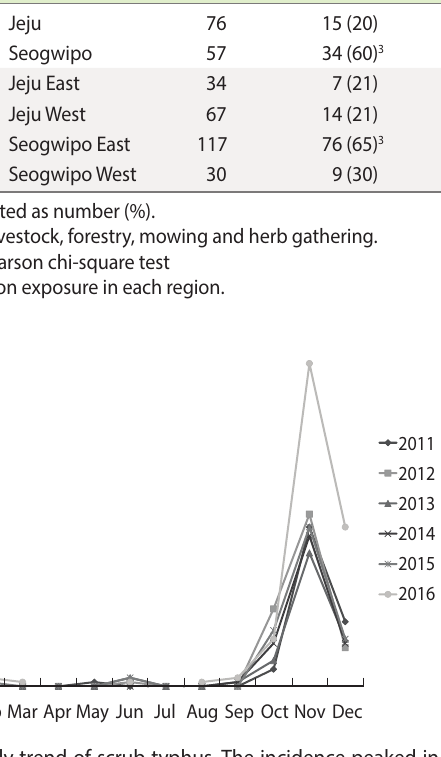
Total Regions (n) Orchard Dry field Hiking